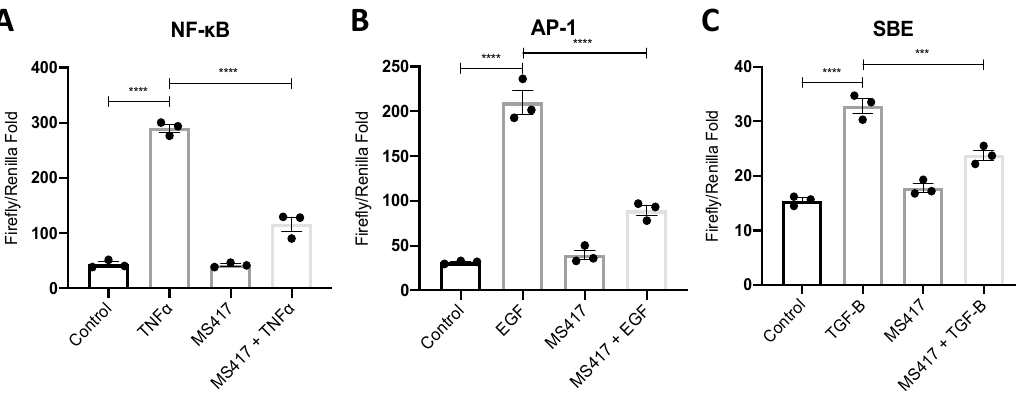
Figure 2. BRD4 inhibition attenuated NF κ B, AP-1, and Smad-Binding Element (SBE) mediated luciferase activity. HK-2 cells were transfected with NF κ B ( A ), AP-1 ( B ) or SBE ( C ) vectors and treated with 1 µ M MS417 for 1 h followed by 10 ng / mL TNFa (NF κ B), 50 ng / mL EGF (AP-1), or 5 ng / mL TGF- β 1 (SBE) treatment. n = 3, *** p < 0.001, **** p < 0.0001.